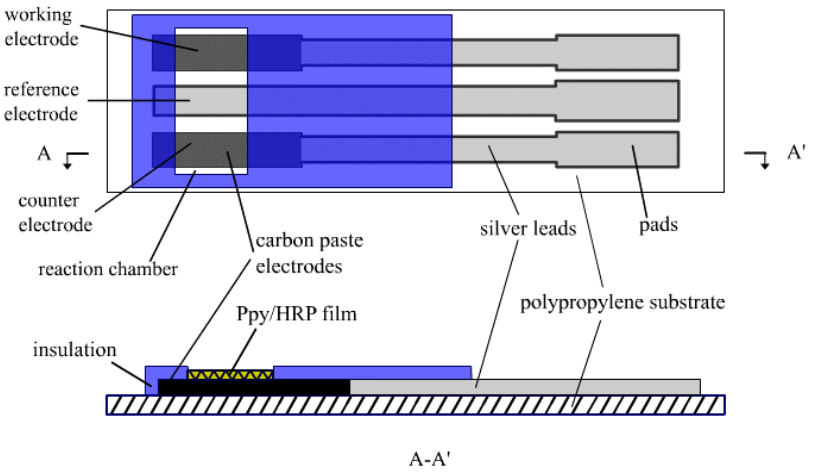
Figure 1. The structure of the screen-printed electrodes, the sensor substrate was 35 mm×10 mm while the working electrode area was 1 mm×2